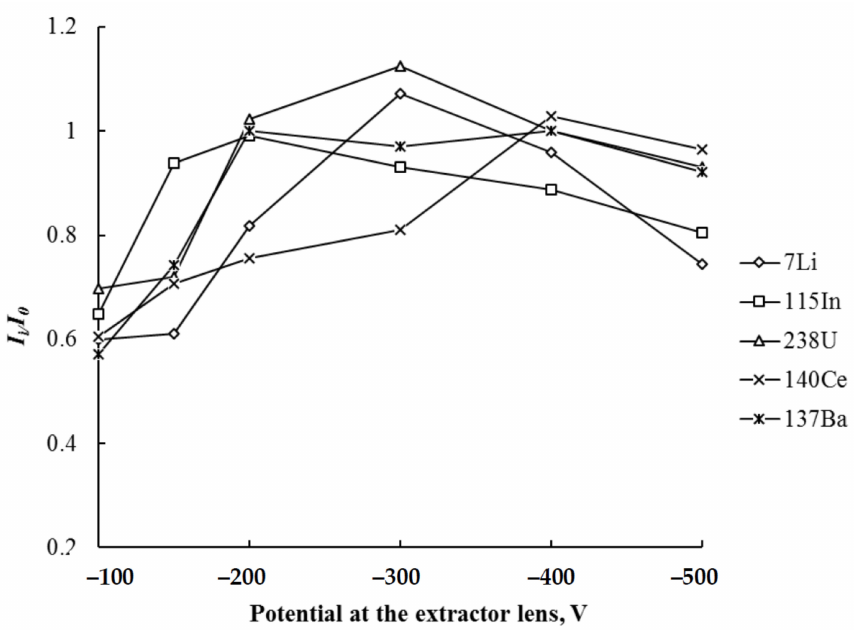
Figure 4. Effect of the potential at the extractor lens on the matrix effect: I 0 —10 µ g/L standard